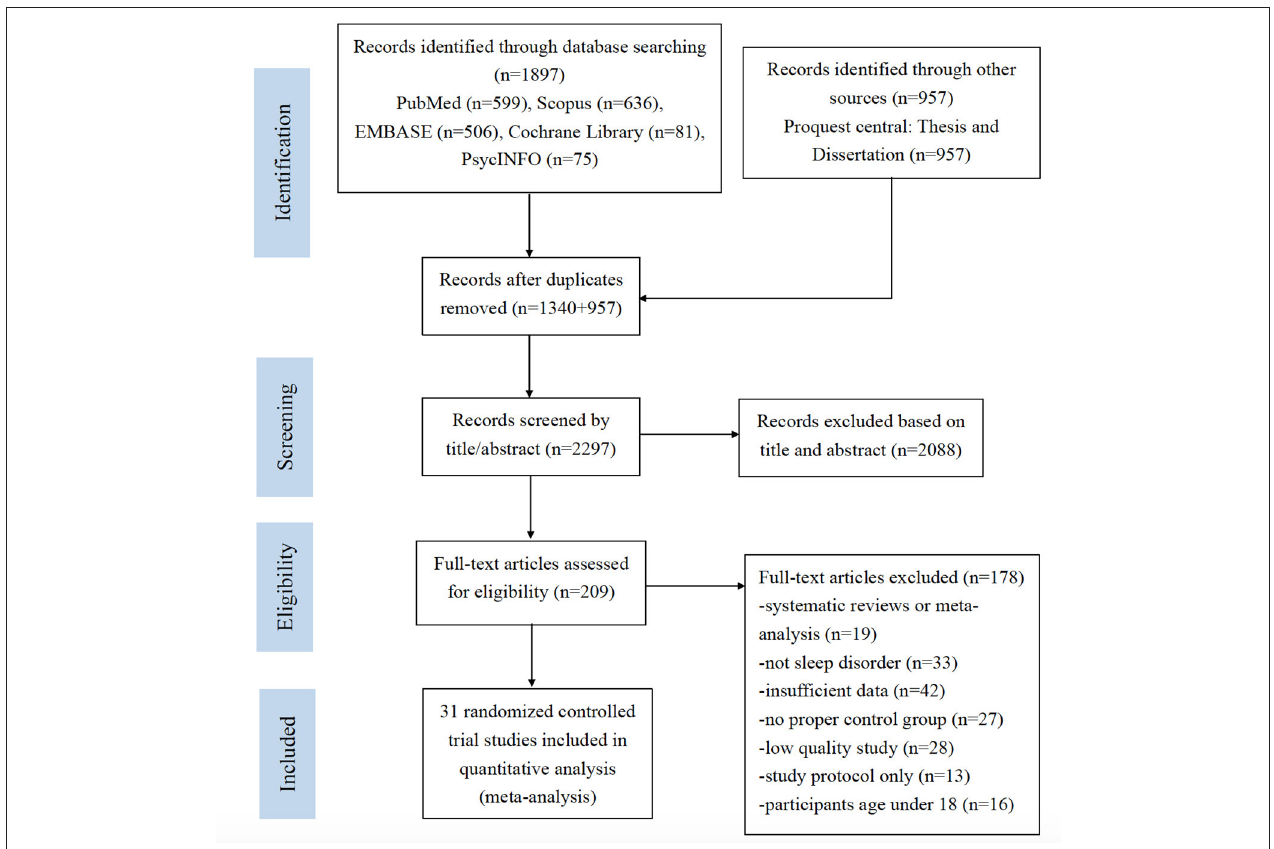
FIGURE 1 | PRISMA flow chart for study